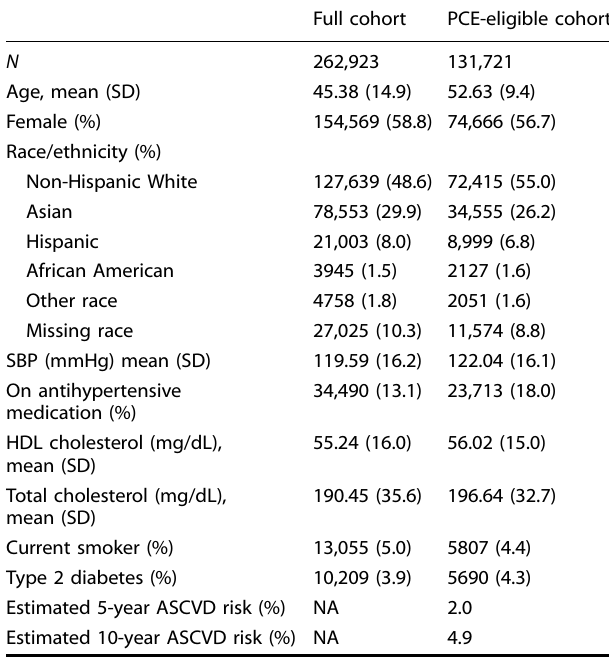
Table 1. Baseline characteristics of the full cohort and PCE-eligible